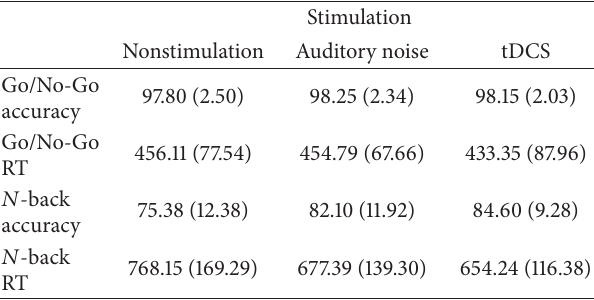
Table 1: Mean values for performance.